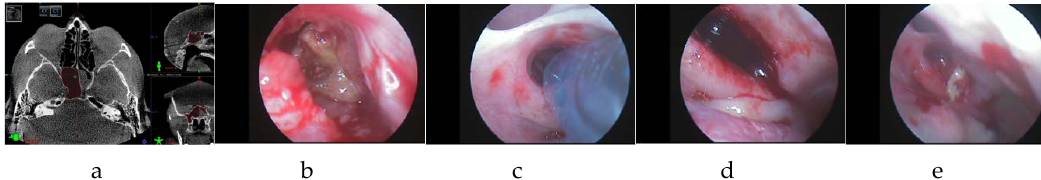
Figure 5. Detailed illustration of a single case where the first measurement indicated that not all fungal masses were removed. After elimination of the fungal masses, a second control measurement was performed. ( a ) Measurement of the sphenoid sinus volume from the CT-scan 3D reconstruction (green color is scan area). ( b ) Fungal ball in the sphenoid sinus. ( c ) Filling in the sinus with the methylene blue solution. ( d ) The sinus filled with the contrast fluid during the initial measurement, indicating a 6.9-cm 3 volume that is well below the 8.8 cm 3 expected from the preoperation CT scan. ( e ) After the second surgical revision and several irrigations, remaining fungal masses were eliminated, indicated by the 8.5 cm 3 volume obtained in the control measurement.